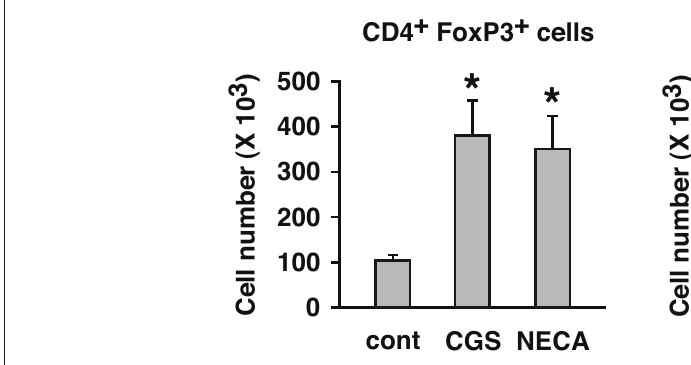
from the result of flowcytometric analysis. The number of H-2K b + CD4 + cells in the beginning of MLC was approximately 1 × 10 6 cells including approximately 1 × 10 5 H-2K b + CD4 + FoxP3 + cells. Data represent average ± SD of three separate experiments. ∗ P < 0 . 01 vs. control